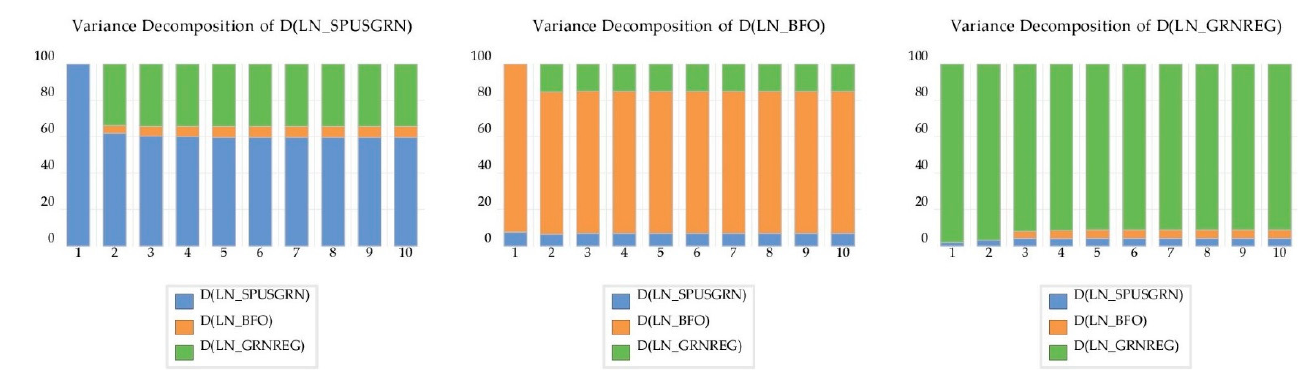
Figure A4. Variance decompositions in model 1 using Cholesky factors.